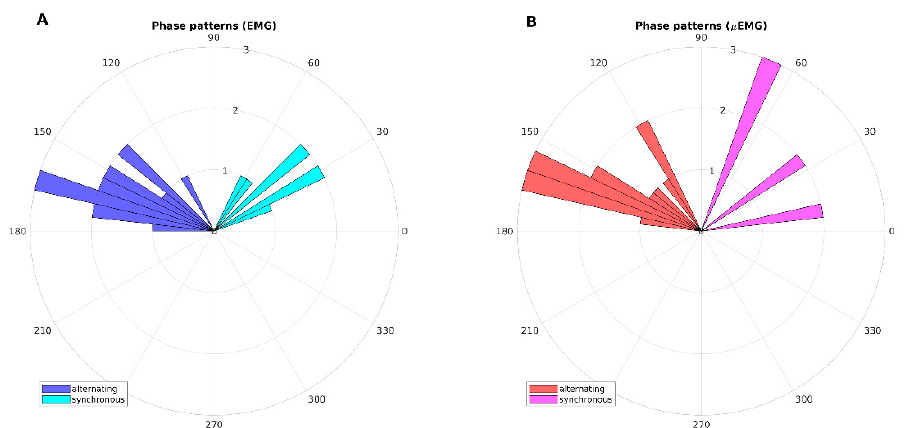
Figure 3. Polar histograms showing phase patterns (phase differences) evaluated with: ( A ) Dantec Keypoint EMG system; ( B ) µEMG experimental wearable device. EMG: electromyography. Table 2. Comparison of frequency and phase difference measurements in patients with Parkinson’s disease and in patients with rET .